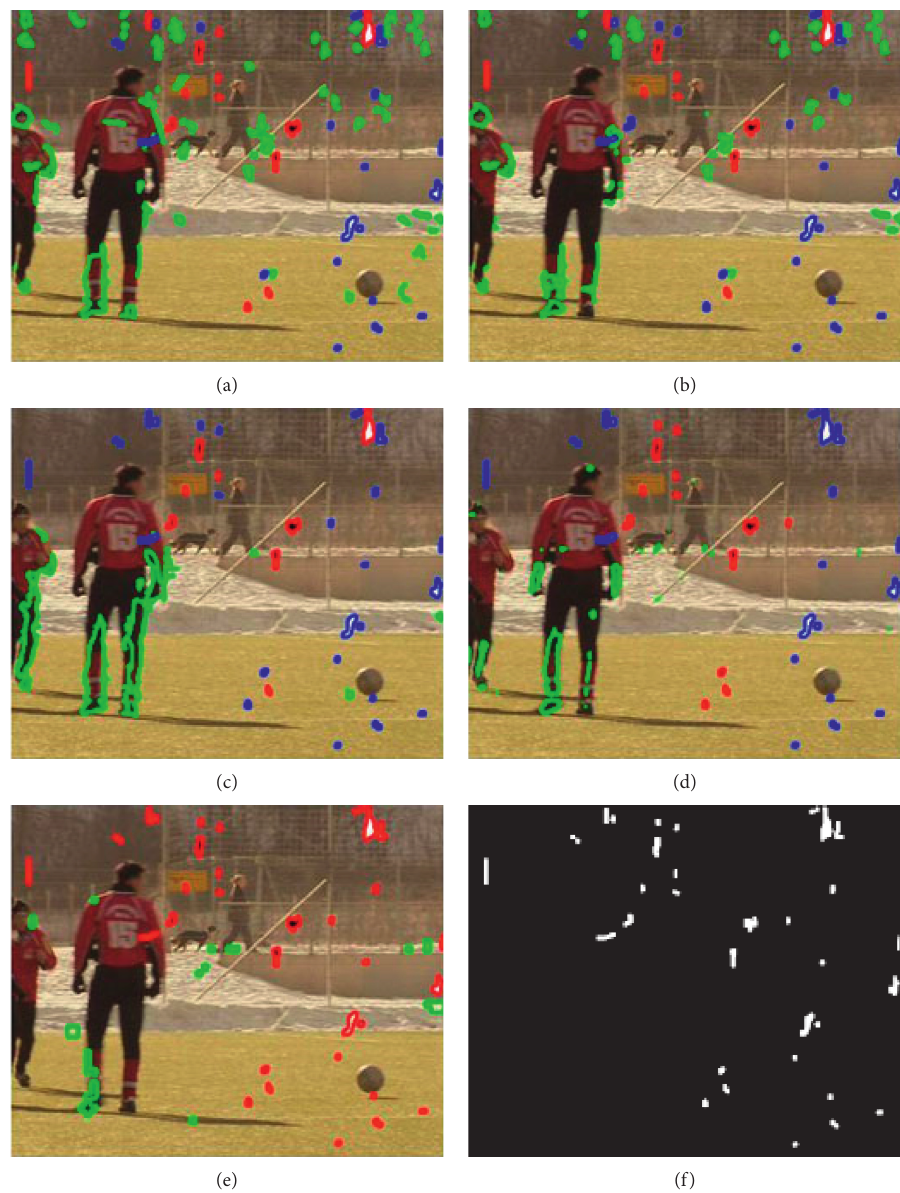
Figure 13: Results of different coloured artificial blotch detection studies for “football_2” dataset: (a) the HOG feature, (b) the LBP feature, (c) the region matching, (d) the SDI, (e) the proposed method, and (f) the mask indicating blotch regions.